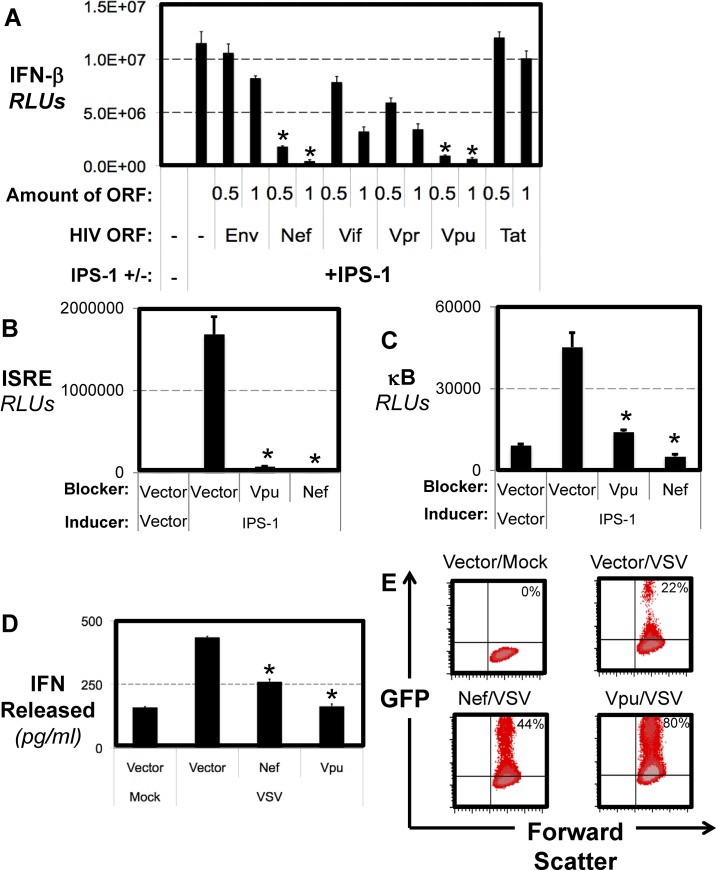
HIV Proteins Block the Antiviral Signalling of IPS-1.(A) IPS-1 overexpression was used to induce IFN-β reporters. HEK 293T cells were cotransfected with expression plasmids for different HIV protein products and the levels of IFN-β luciferase were determined. Reporter activation in A-C was measured, and graphed in relative light units normalized to cotransfected Renilla luciferase (designated RLUs). * are values with p<1x10-4 as compared to IPS-1 alone. (B) HEK 293T cells were co-transfected with IPS-1 and vector control, Vpu or Nef and an ISRE reporter. * are values with p<1x10-3 as compared to IPS-1 alone. (C) HEK 293T cells were co-transfected with IPS-1 and vector control, Vpu or Nef and a κB reporter. * are values with p<1x10-3 as compared to IPS-1 alone. (D) CEM cells were stably transduced with either Vpu or Nef. The cells were then infected with VSV that expresses GFP upon active infection. After 48 hours, supernatants were collected and monitored by ELISA for the amount of secreted IFN. * are values with p<1x10-4 as compared to vector infected cells. (E) In addition, cells were collected from the infection in D and assayed for GFP levels, an indicator of VSV replication in the culture.